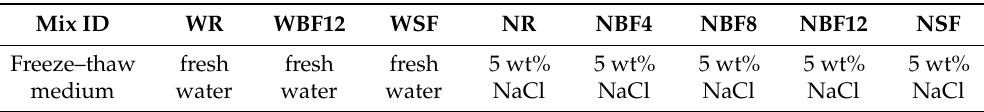
Table 6. Freeze–thaw cycle test grouping.